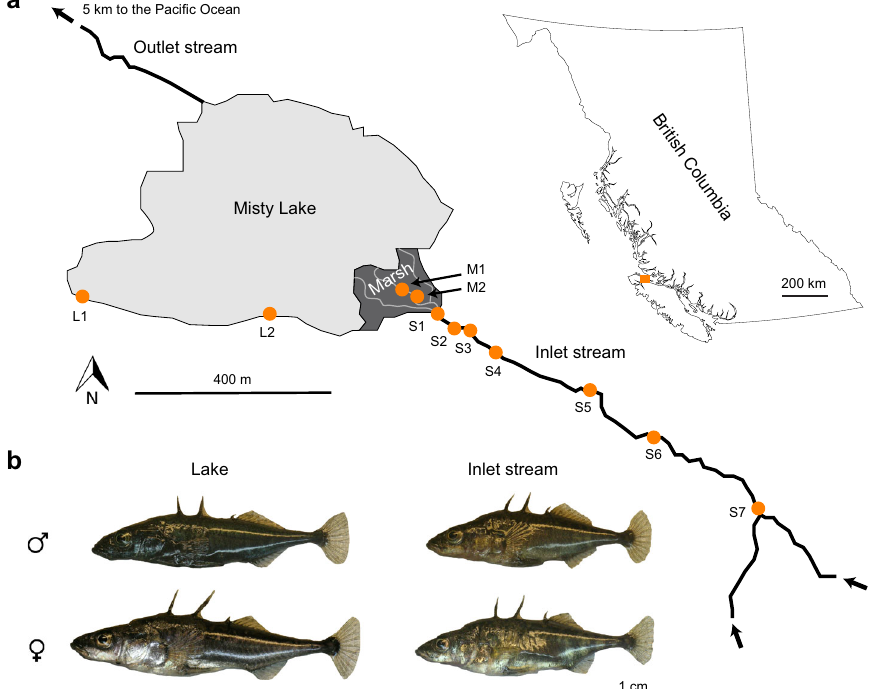
Fig. 1 The Misty Lake and inlet stream stickleback system. a Geographic situation of Misty Lake, its inlet stream, and the marsh located between these habitats (map created by the authors based on data from Google Earth). Sample sites along the lake-stream transition are indicated by orange dots (GPS coordinates and sample sizes given in Supplementary Table 1). b Representative lake and stream stickleback individuals of both sexes (Photo credit: Katja